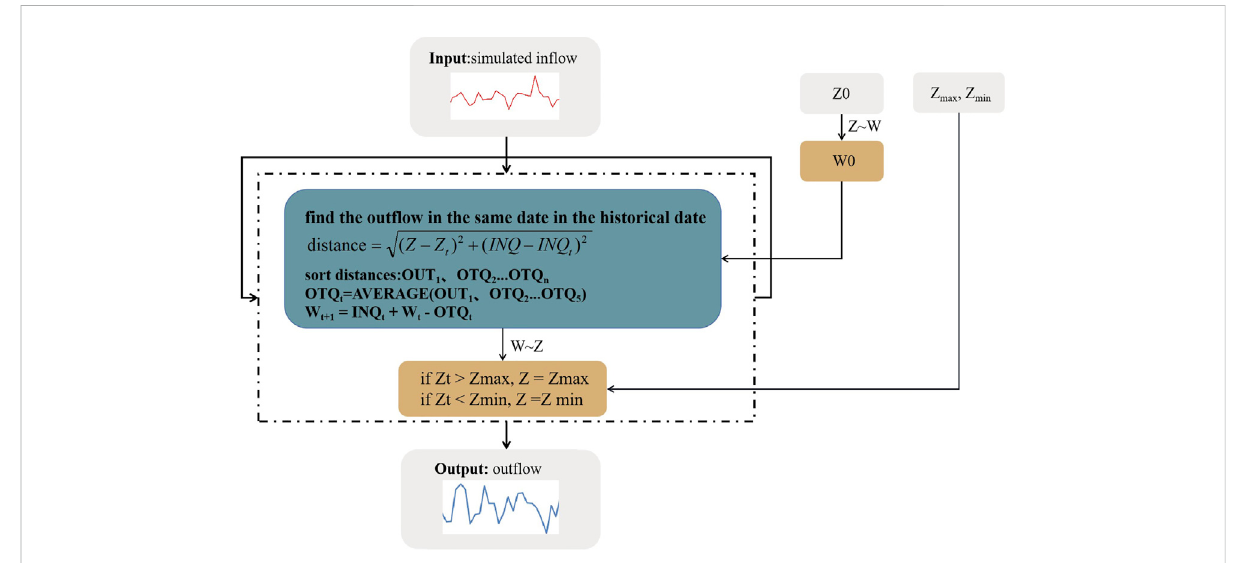
FIGURE 4 Flow chart of reservoir out fl ow process